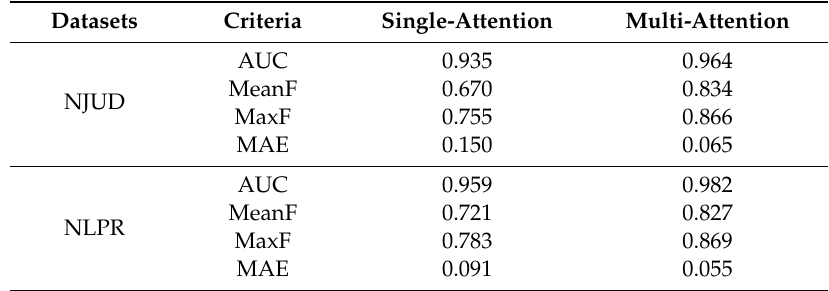
Table 2. Performance of HANet During Ablation Study on NJUD and NLPR